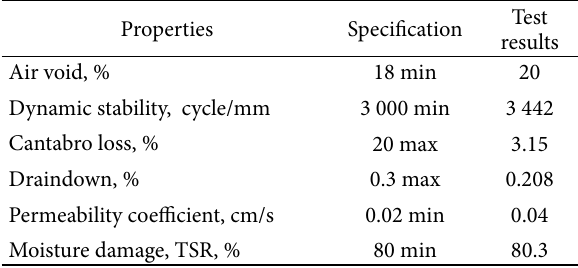
Table 1. Laboratory test results from porous asphalt mixtures and corresponding requirements in specification